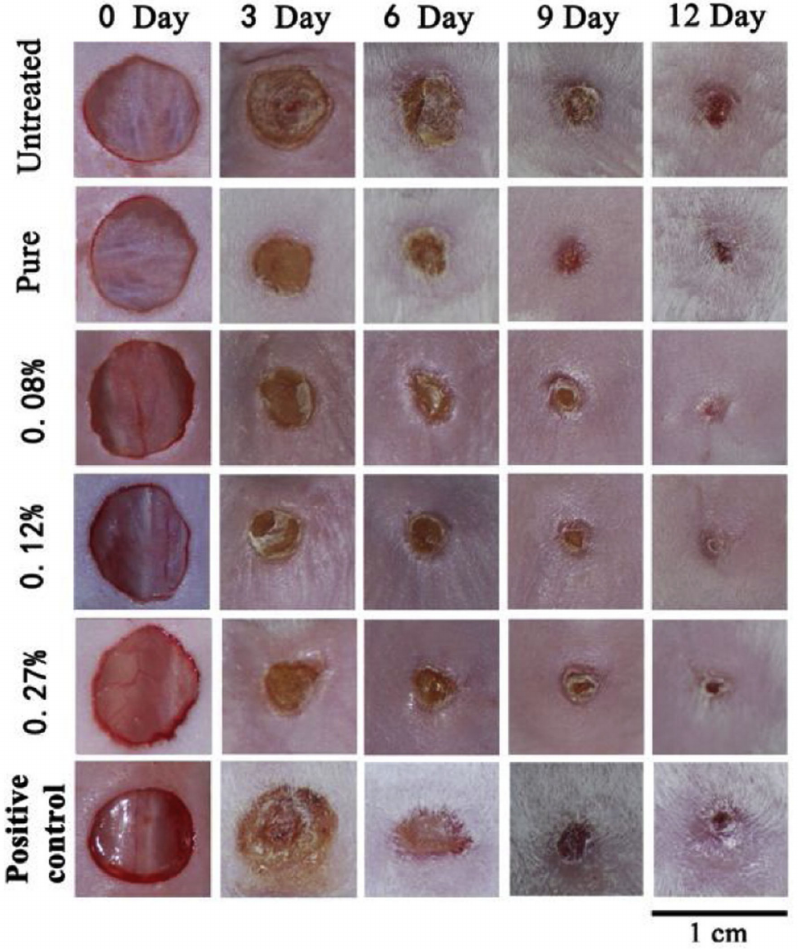
Figure 21. Stages of wound healing effects on mice with different levels of treated groups. Reprinted from [64]. Copyright 2020 with permission from